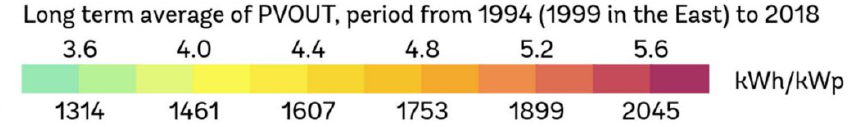
Figure 1. Solar atlas map of Morocco for 2020 by World Bank [6] augmented with selected Moroccan airports. PVOUT = specific photovoltaic power output. kWp = kW peak.